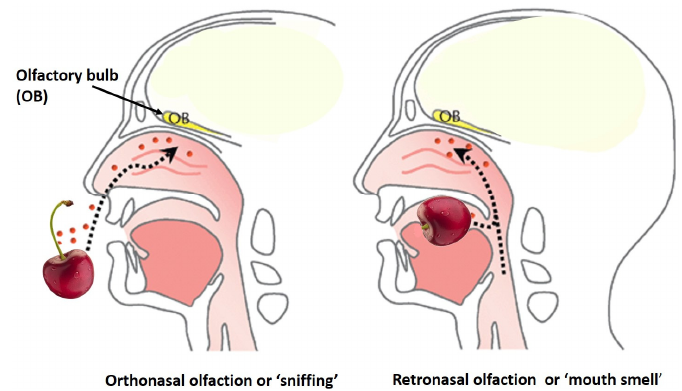
Figure 3. Orthonasal olfaction or ‘sniffing’ in contrast to retronasal olfaction, occasionally referred to as ‘mouth smell’.